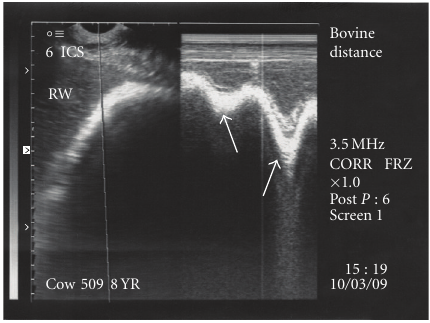
Figure 7: Partial biphasic reticular motility (arrows) seen at the level of 6th intercostal space on B+M mode